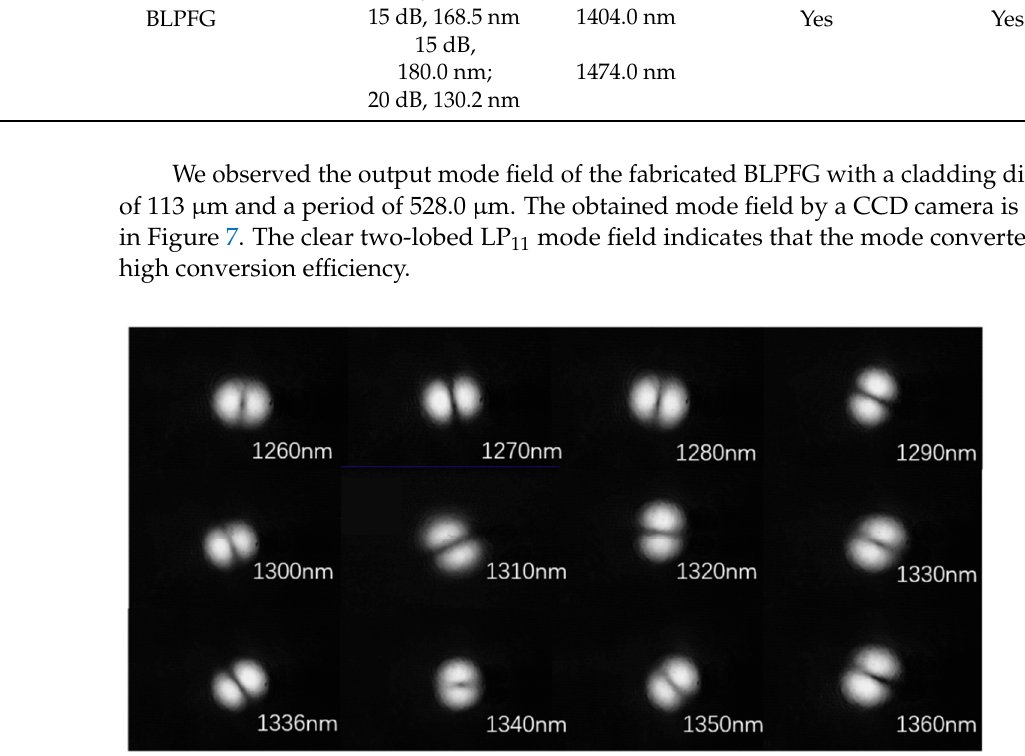
Figure 7. The output modes of the BLPFG in its working window. Table 3. Data comparison of different methods to increase the mode conversion bandwidth in recent years.